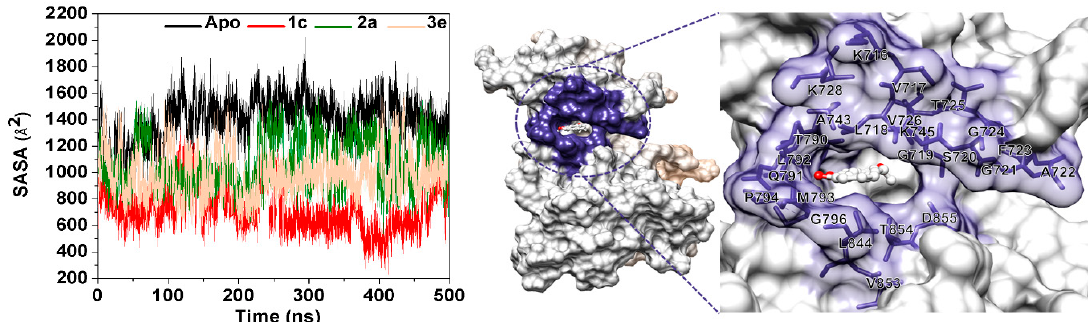
Figure 7. Solvent-accessible surface area (SASA, Å 2 ) of the apo form and three chalcone complexes along the 500-ns MD where the amino acids within a 7-Å sphere of chalcone used for the SASA calculations are also shown on the right-hand side.